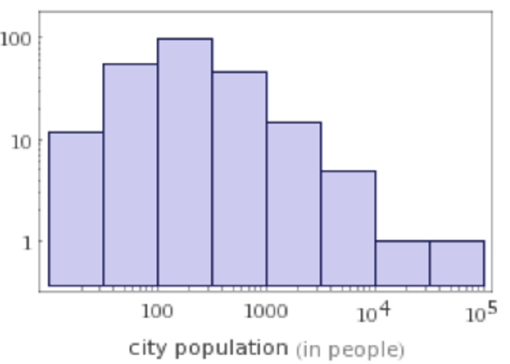
Figure 1. Logarithmic distribution of the population in the municipalities of Teruel province.